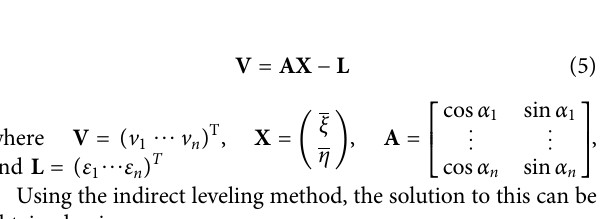
FIGURE 1 | Trajectories of IS-2 (left) and Jason-2 (right) over the SCS.